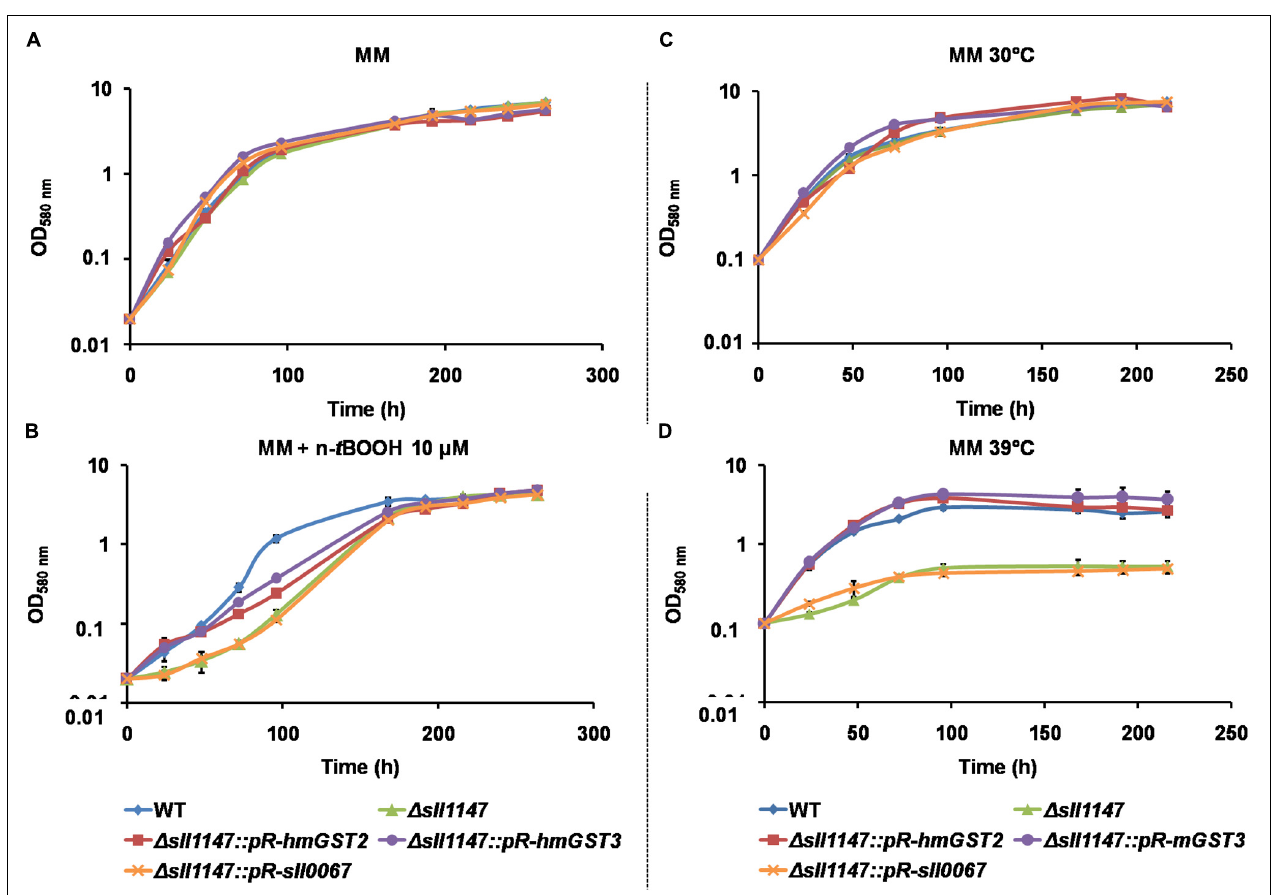
FIGURE 7 | The human hmGST2 and hmGST3 proteins can restore the (cid:49) sll1147 tolerance to heat and n- t BOOH. (A,B) Growth curve of Synechocystis WT and relevant reporter strains (initial OD 580 nm = 0.02) incubated in liquid MM under standard light (2500 lux; 31.25 µ E.m − 2 .s − 1 ) and temperature (30 ◦ C), without (A) or with n- t BOOH 10 µ M (B) . (C,D) Growth curve of WT and relevant reporter strains (initial OD 580 nm = 0.1) incubated in liquid MM under standard light (2500 lux; 31.25 µ E.m − 2 .s − 1 ) at 30 ◦ C (C) or 39 ◦ C (D) . Data shown in all panels are expressed as the mean ± SD of three experiments.